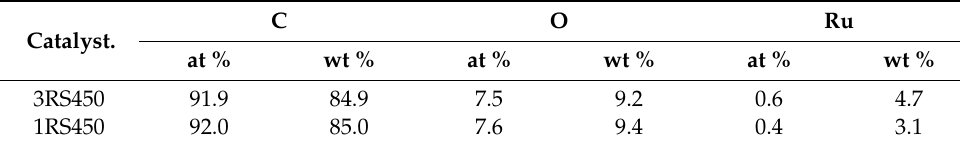
Table 3. Surface elemental composition of the catalyst determined by XPS.